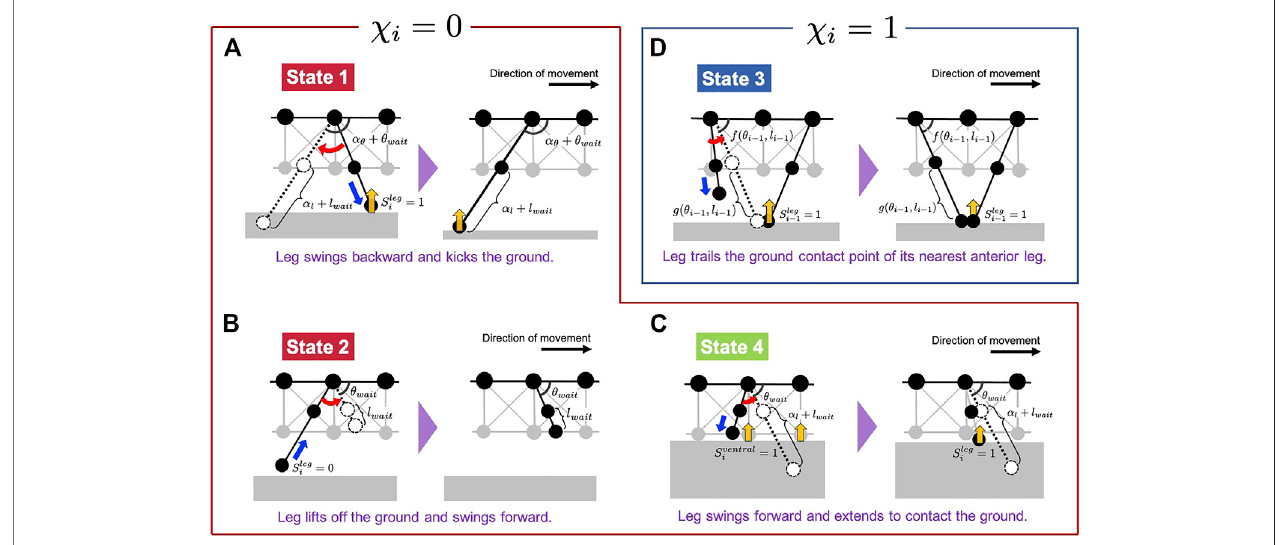
FIGURE 4 | Schematic of the leg control rules proposed in our model. Sub fi gures (A – D) correspond to States 1, 2, 4, and 3, respectively. The legs, illustrated in dashed lines, denote the target positions in each situation.